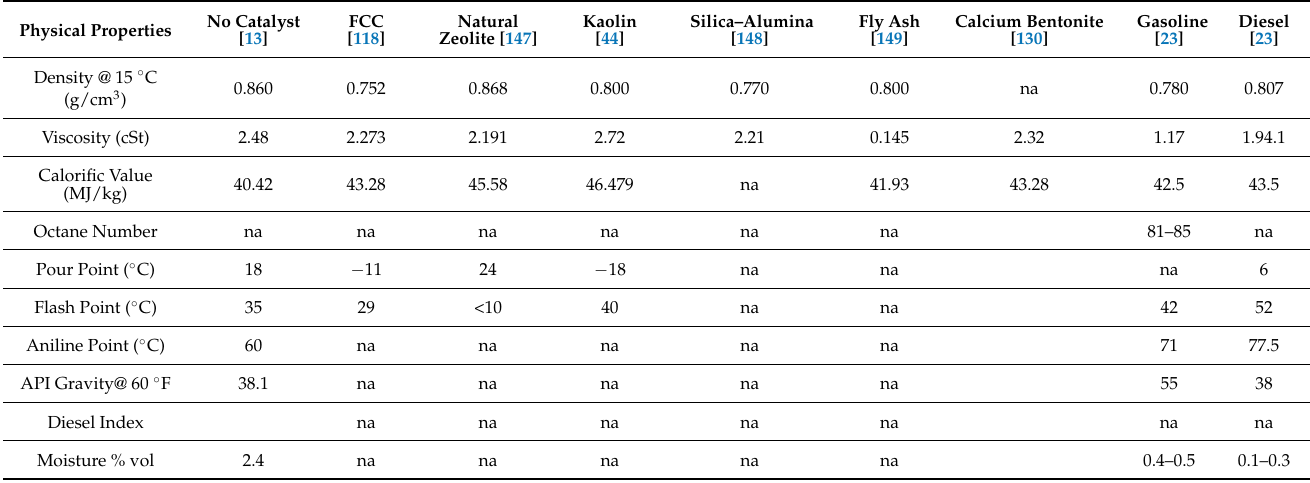
Table 4. Physicochemical properties of the liquid